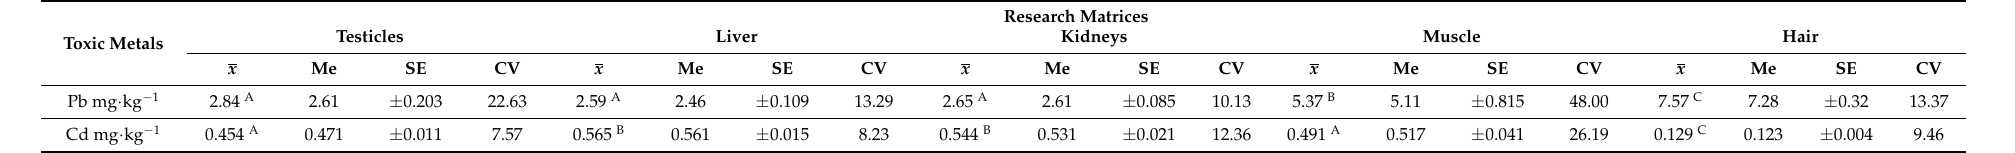
Table 3. The variability factor and content of Pb and Cd in tissues and organs of red deer (mg · kg − 1 of